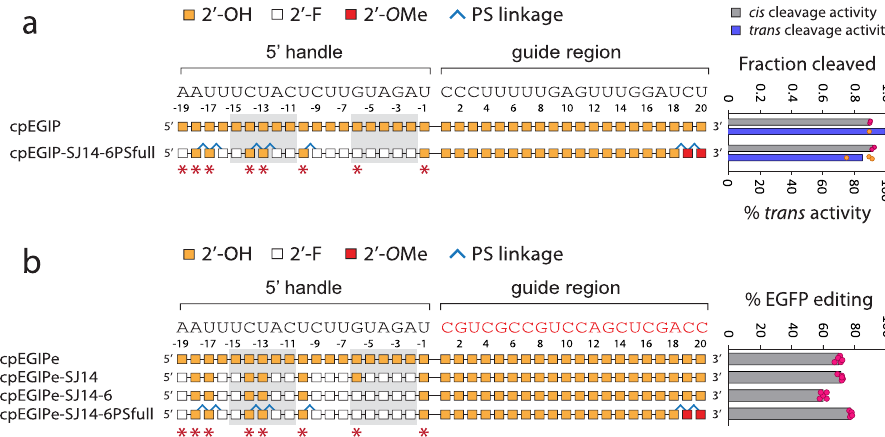
Fig. 6 In vitro cis and trans cleavage activity and cell-based editing of As Cas12a using a heavily modi fi ed pseudoknot crRNA guide. Chemical modi fi cation patterns are illustrated with corresponding mean in vitro cis and trans activity ( n = 2) ( a ) or mean cell-based editing ( n = 5) ( b ) shown to the right. Error bars are standard deviation and replicates are biological. Nucleotides of the 5 ′ handle that are predicted from structural data to make polar contacts through 2 ′ -OH hydrogen bonding are indicated with red asterisks below. The base-paired stem nucleotides of the 5 ′ handle pseudoknot are enclosed with light gray boxes. In vitro cleavage and cell-based editing assays utilize the distinct guide sequences that are shown above each schematic. Source data are provided as a Source Data fi